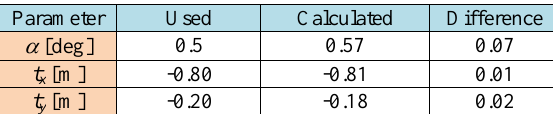
Table 2. Affine transformation used and calculated via